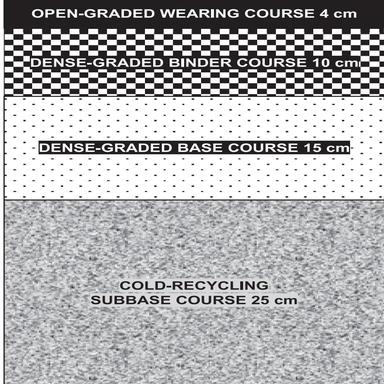
Typical cross section and nominal thickness for each layer.